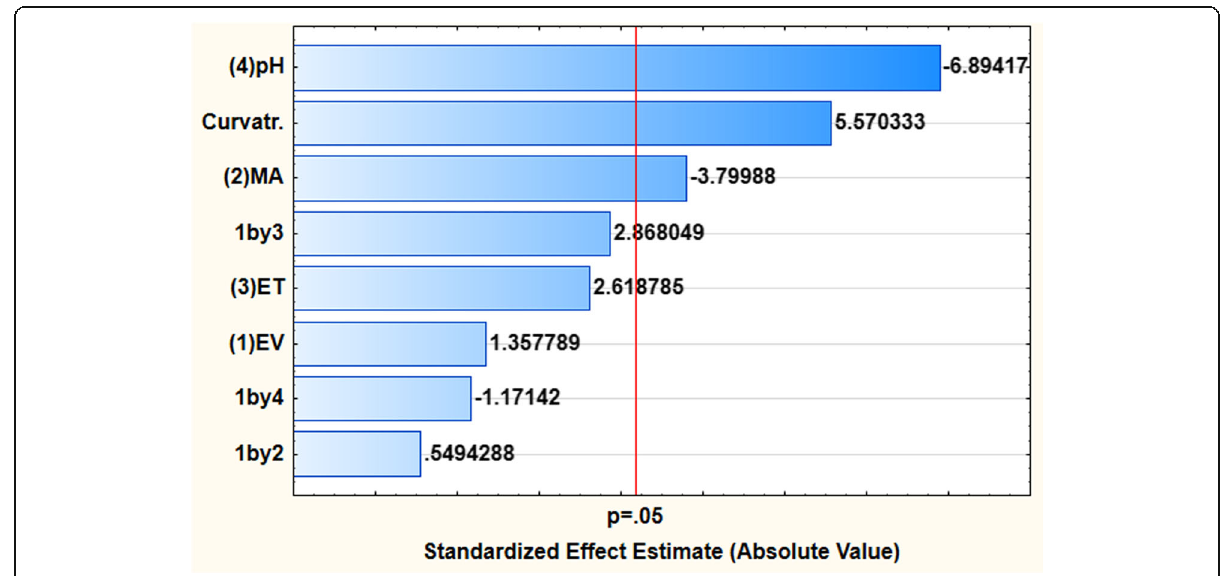
Fig. 7 Pareto chart of standardized effects for variables in the preconcentration of CBZ